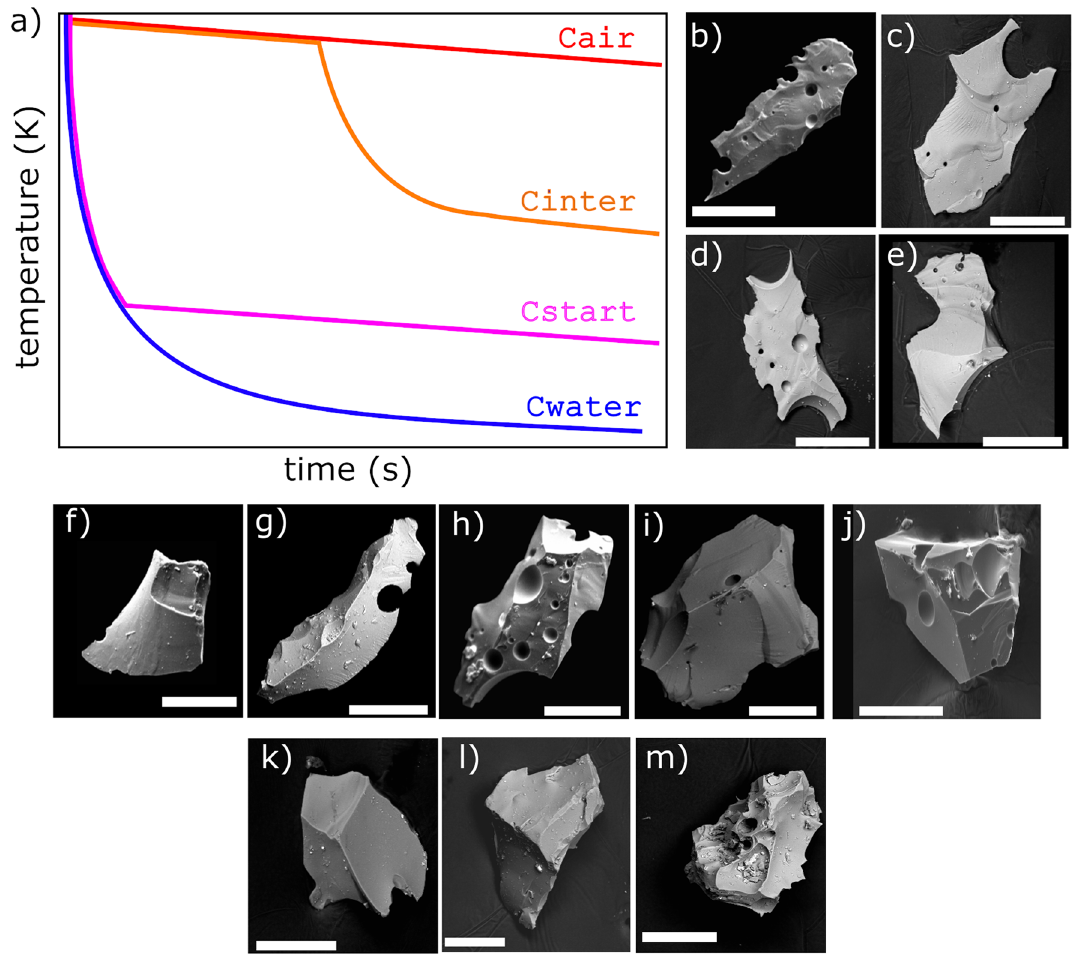
Figure 1. Experimental and natural particles used for demonstration. ( a ) Schematic cooling curves for the crucible-contraction run samples “Cair”, “Cinter”, “Cstart” and “Cwater”. SEM scans show typical particles from the analysed samples: ( b ) “Cair”, ( c ) “Cinter”, ( d ) “Cstart”, ( e ) “Cwater”, ( f ) “B”, ( g ) “D”, ( h ) “R”, ( i ) “F”, ( j ) “V”, ( k ) “U”, ( l ) “NATcp”, ( m )